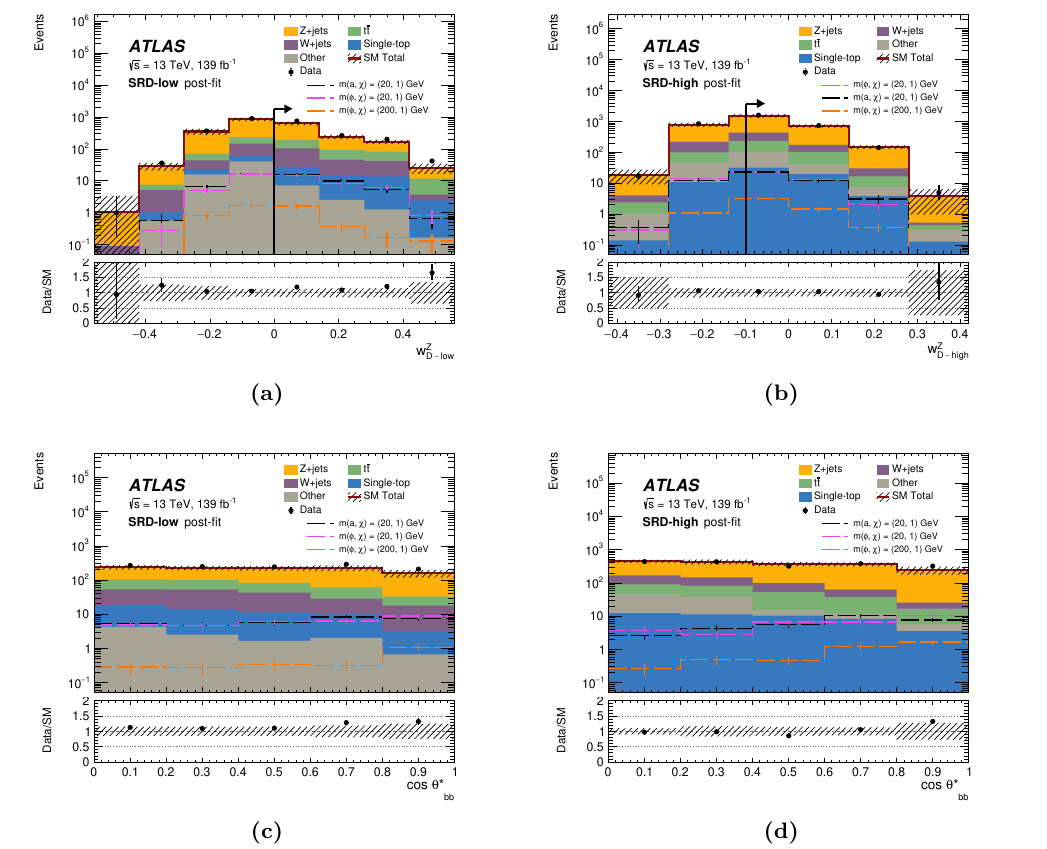
and (c) cos θ ∗ in SRD-low and (b) w Z and (d) Figure 7 . Post-fit distribution of (a) w Z D-high D-low bb cos θ ∗ in SRD-high. Where relevant, the signal region selection is indicated by a black arrow. bb In each of (a)–(d) the lower plot shows the ratios of the observed yields to the post-fit predicted background yields. The “Other” category includes contributions from diboson and t ¯ t + W/Z/H production. The shaded band represents the total uncertainty of the background prediction. The last bin includes the overflow